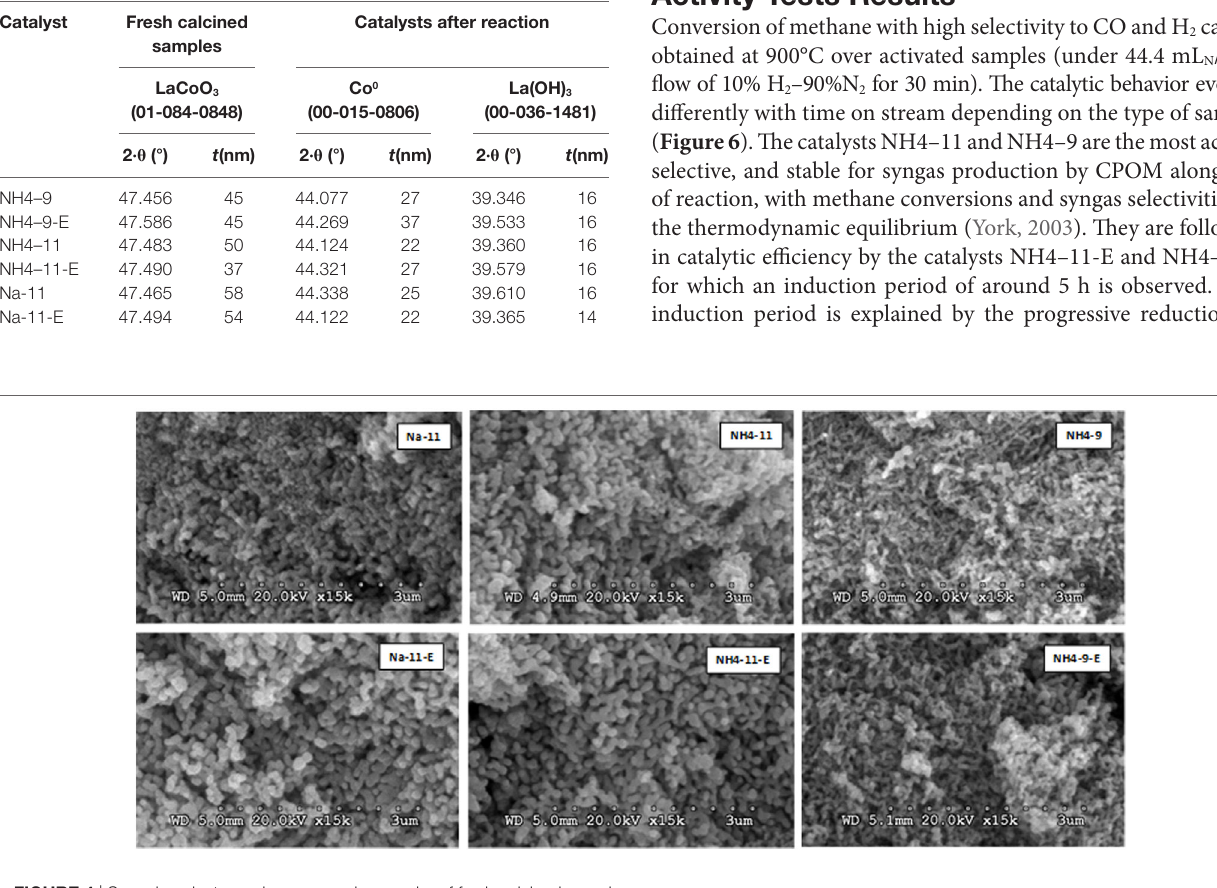
FigUre 4 | Scanning electron microscopy micrographs of fresh calcined samples.